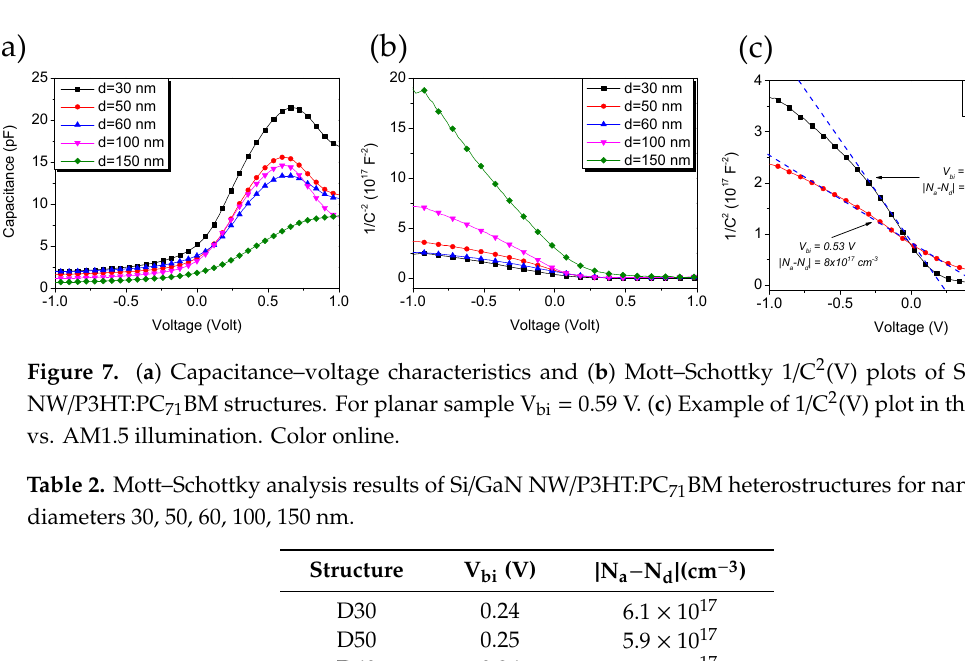
diameters 30, 50, 60, 100, 150